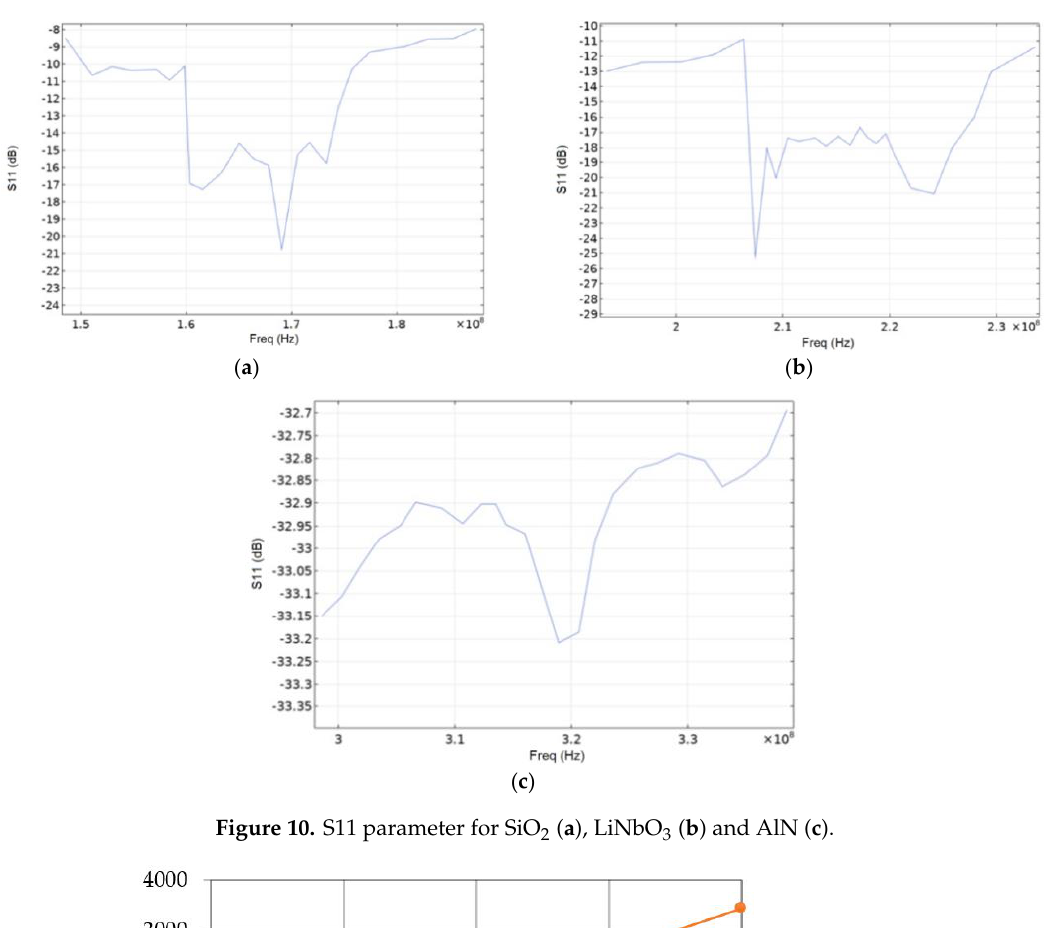
Figure 10. S11 parameter for SiO 2 ( a ), LiNbO 3 ( b ) and AlN ( c ).